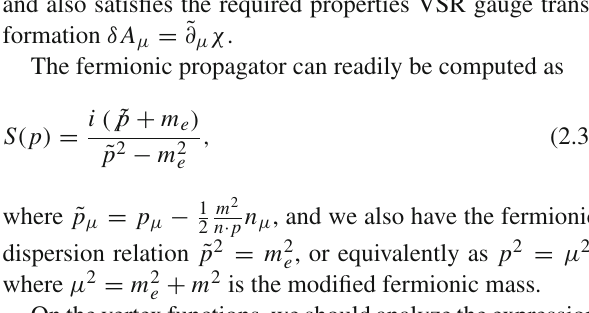
and also satisfies the required properties VSR gauge trans- ˜ ∂ formation δ A μ = μ χ